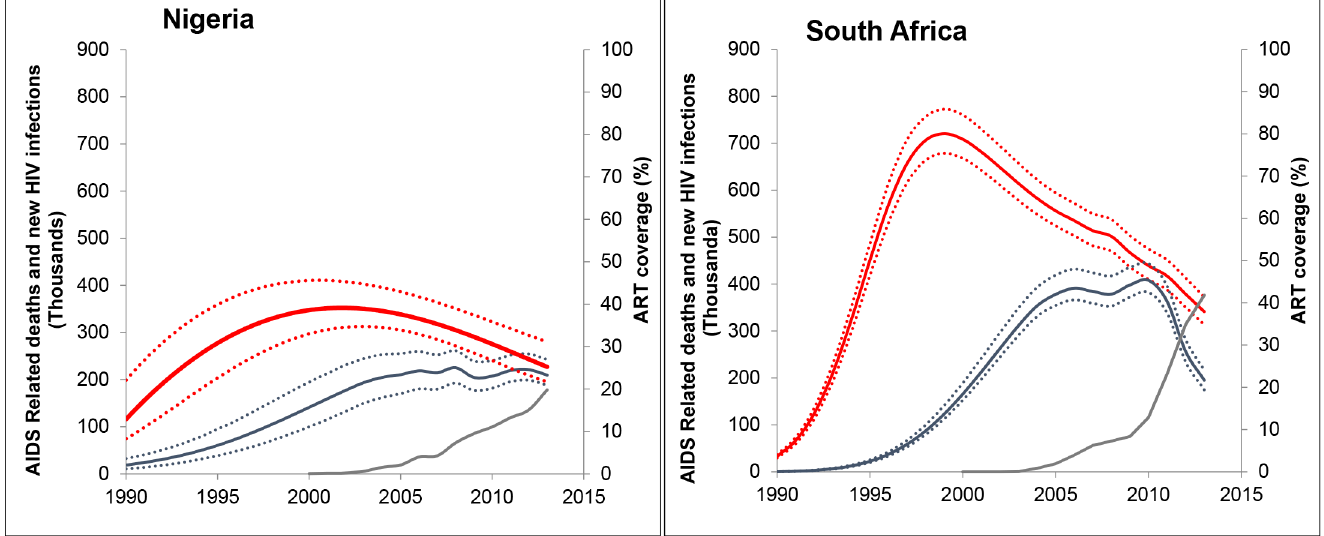
Fig 4. Trends in estimated new infections, AIDS-related deaths and ART coverage in Nigeria and South Africa, 1990 – 2013. Trends with uncertainty bounds for new infections (red), AIDS-related deaths (blue), and ART coverage percentage (green), 1990 to 2013. ART coverage is calculated as the percentage of people reported on ART among the estimated people living with HIV for the same time period.